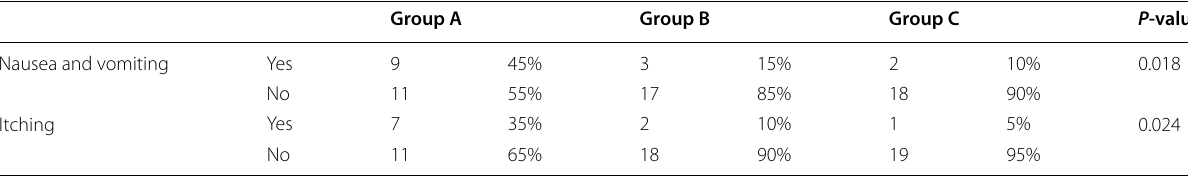
Data are presented as mean and standard deviation The incidence of postoperative nausea & vomiting and itching was greater in the epidural group (group A) than in the femoral and adductor groups P value less than 0.05 was considered statistically significant